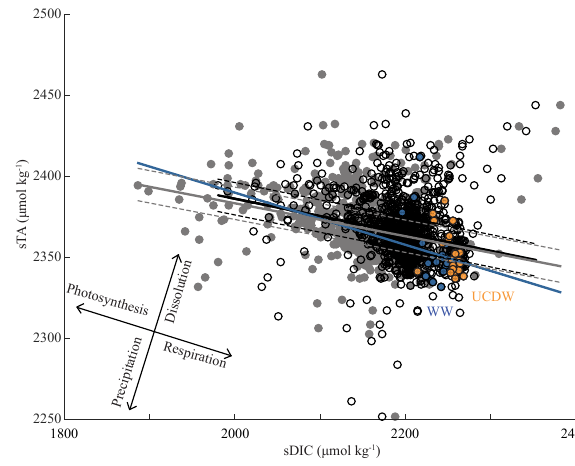
Figure 5. Scatterplots of dissolved inorganic carbon (DIC, µmolkg − 1 ) illustrated as diamonds and total alkalinity (TA, µmolkg − 1 ) illustrated as dots as a function of salinity. The data points are color-coded by the aragonite saturation state ( (cid:127) arag ) . The solid lines illustrate the dilution lines using S = 34.7, TA = 2350µmolkg − 1 , and DIC = 2253µmolkg − 1 as end members for UCDW, and S = 0, TA = 300µmolkg − 1 , and DIC = 300µmolkg − 1 as end members for meltwater (Yamamoto-Kawai et al., 2009). WW: winter water ( T ≤− 1.2 ◦ C; 33.85 ≤ S ≤ 34.13); UCDW: Upper Circumpolar Deep Water (1.7 ◦ C ≥ T ≤ 2.13 ◦ C; 34.54 ≤ S ≤ 34.75) following (Martinson et al., 2008).